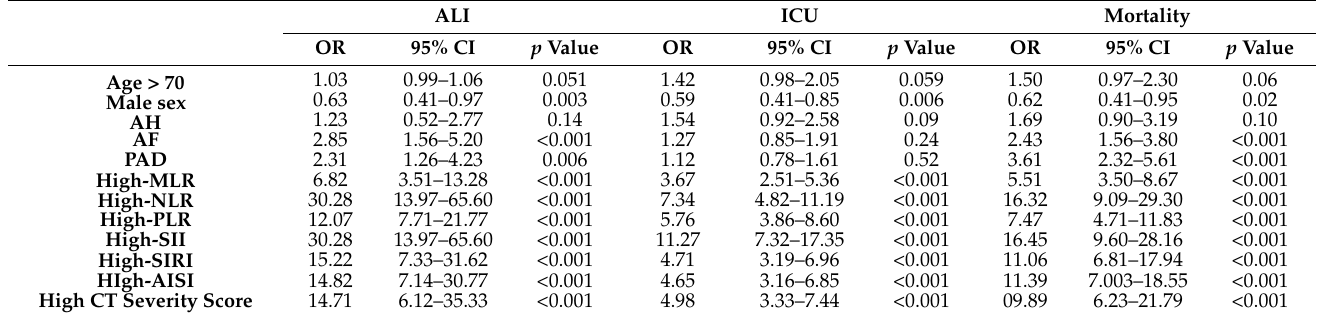
Table 5. Multivariate analysis of new adverse events occurred during the entire study period.